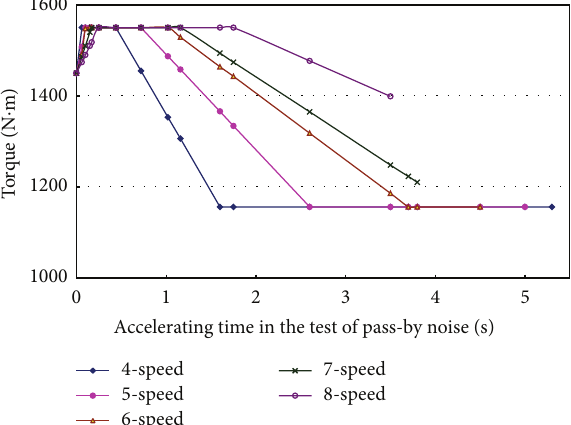
Figure 3: The time curve of pass-by noise with the different gear- boxes in 6-speed.